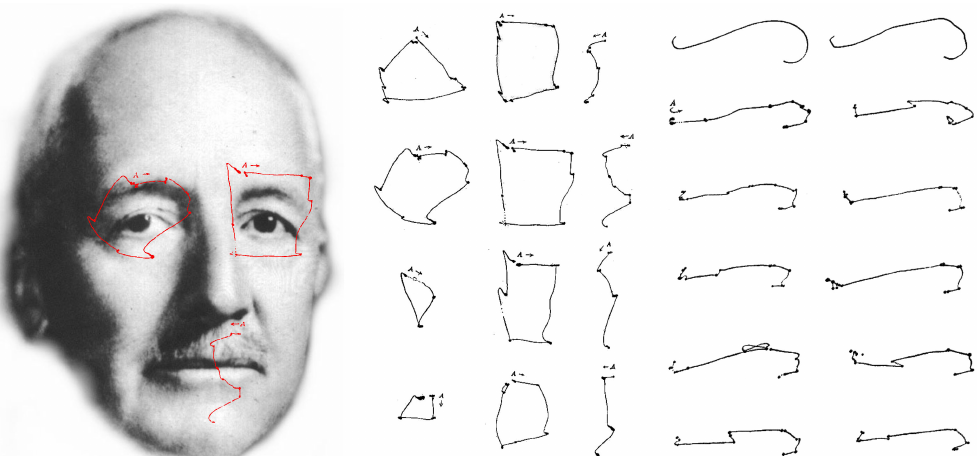
Figure 10. Stratton’s symmetries . Left, Stratton and his eye movement records (in red) for tracking a circle, a rectangle and an S- shape. Centre, the tracings of two observers when following the shapes (upper two) and those of the same observers when imagining the shapes (lower two). Right, an observer viewed the top two patterns on separate trials with the eye movements tracings shown below. (Portrait derived from a photograph kindly provided by Karen De Valois, and a conventional photographic copy can be found in Wade & Tatler, 2005; eye movement patterns from Stratton,